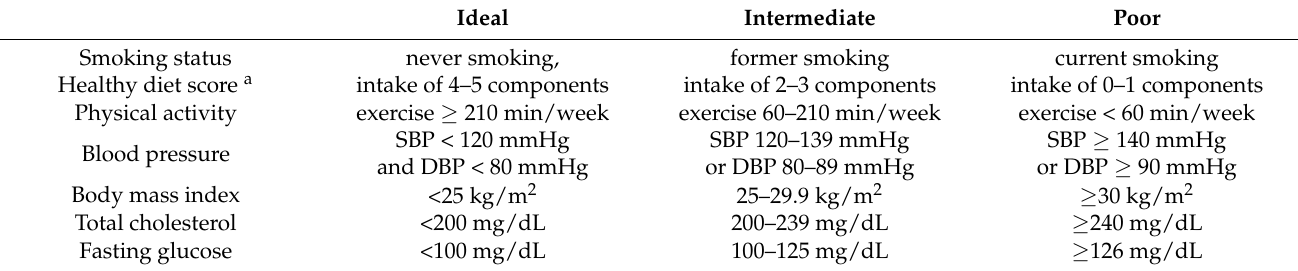
Table 1. The ideal, intermediate, and poor definition of each component of CVH metrics. Ideal Intermediate